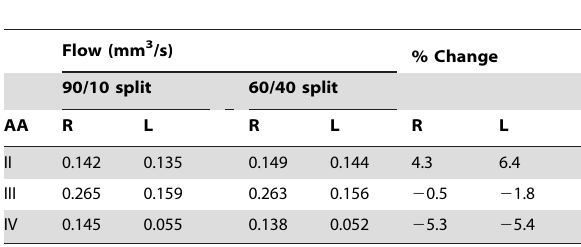
Table 3. Stage 18 AA flow distribution in 90/10 and 60/40 trunk/cranial flow split boundary